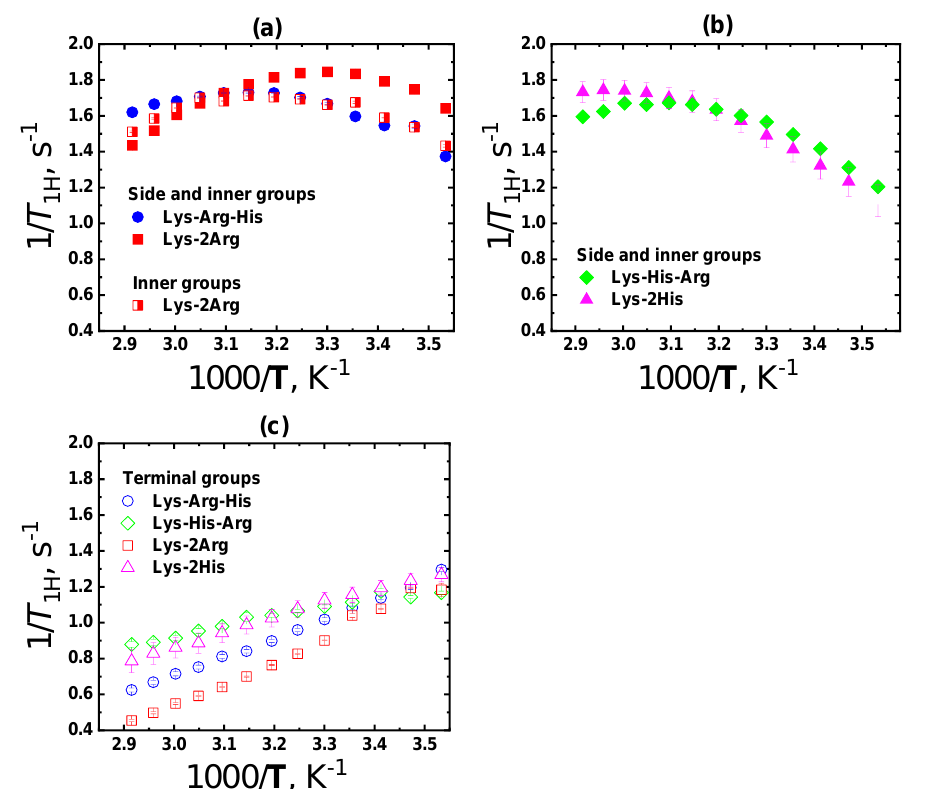
Figure 8. Temperature dependences of the spin − lattice relaxation rate, 1/T 1H : of ( a ) side and inner CH 2 groups of the Lys-Arg-His and Lys-2Arg dendrimers and inner groups of Lys-2Arg; ( b ) side and inner CH 2 groups of the Lys-His-Arg and Lys-2His dendrimers; ( c ) terminal groups of Lys-Arg-His, Lys-His-Arg, Lys-2Arg and Lys-2His dendrimers. In the framework of the dipole–dipole relaxation mechanism of 1 H nuclei (protons), the 1/ T 1H function can be written as [63–67]: